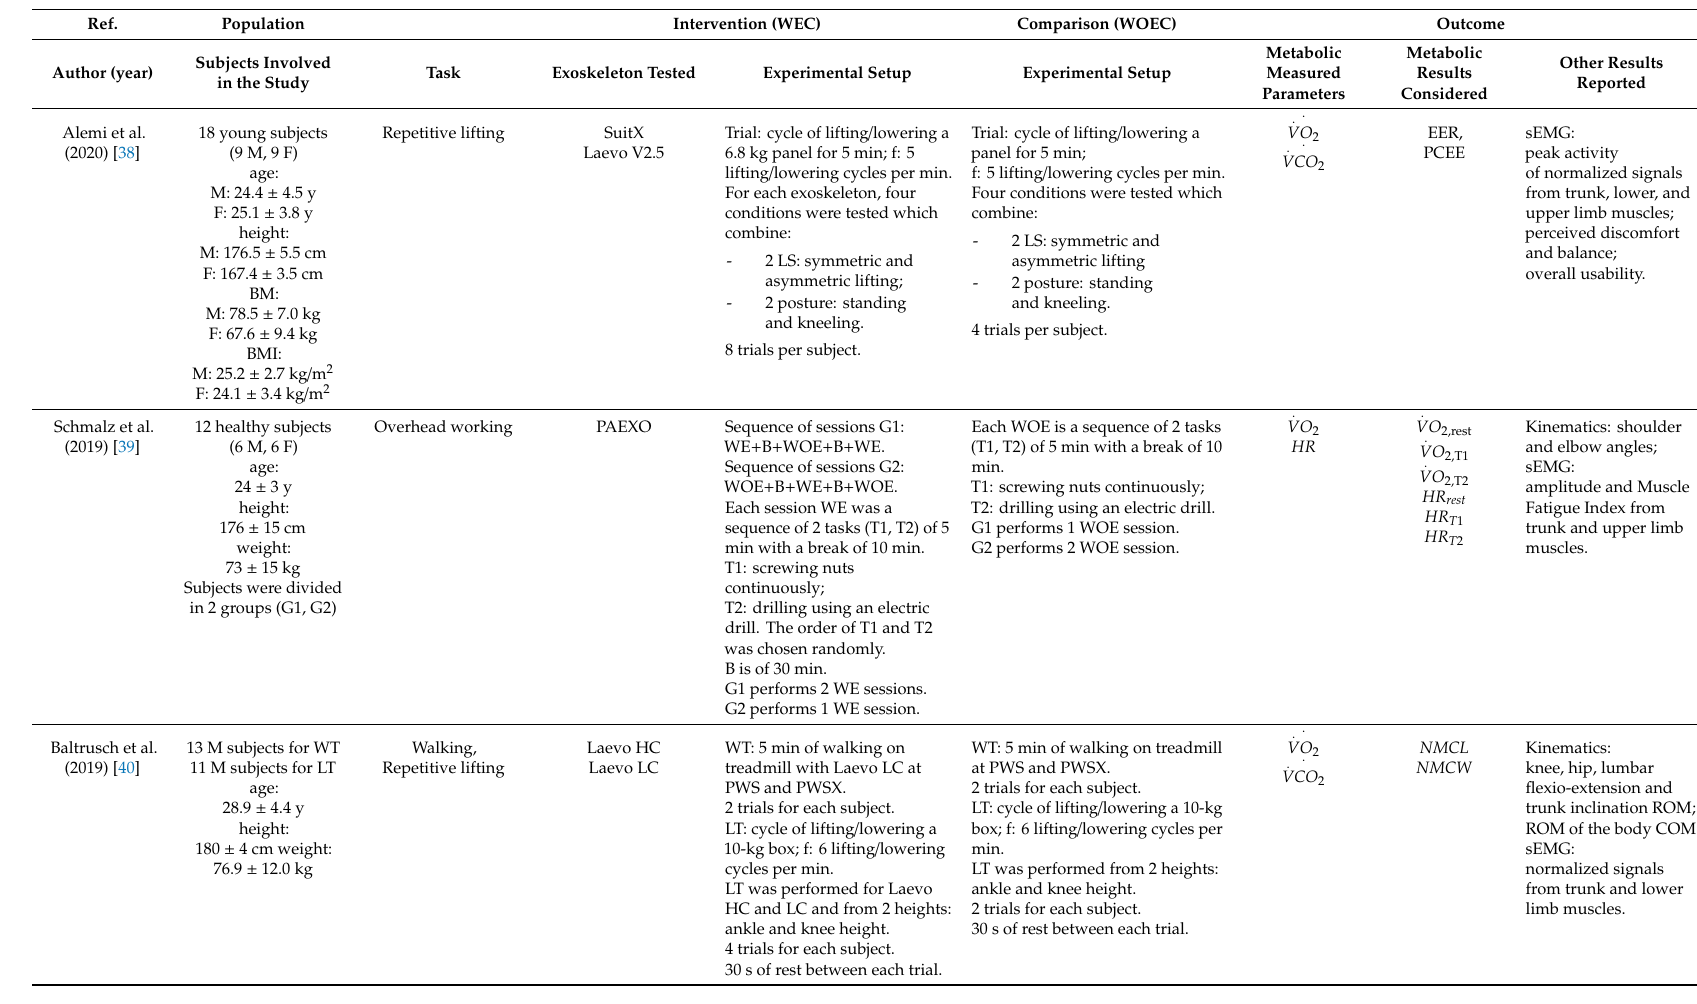
Table 1. Descriptive analysis of the studies considered in the review according to the PICO